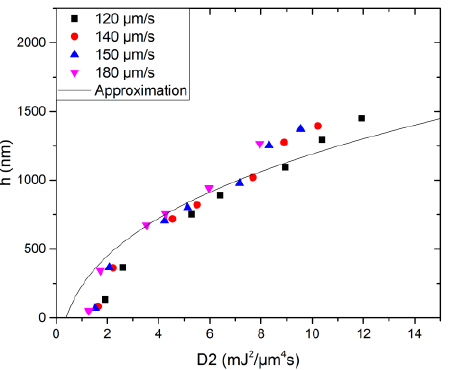
Figure 10. Dependence of volumetric lithography element half-height on the D 2 value.